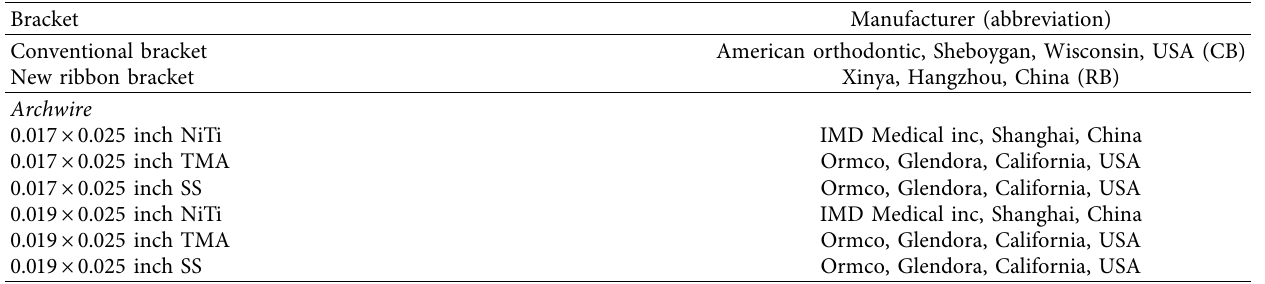
Table 1: Brackets and archwires were used in this study.